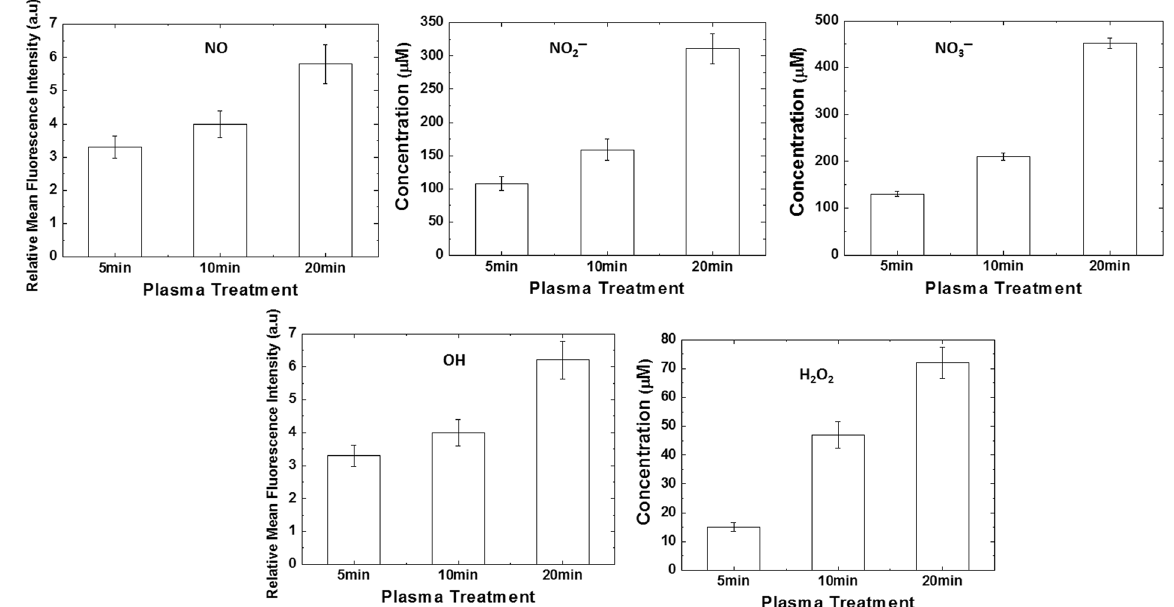
Figure 6. Analysis of reactive oxygen and nitrogen species detection in phosphate buffer after treatment with DBD plasma for different time intervals such as 20, 10 and 5